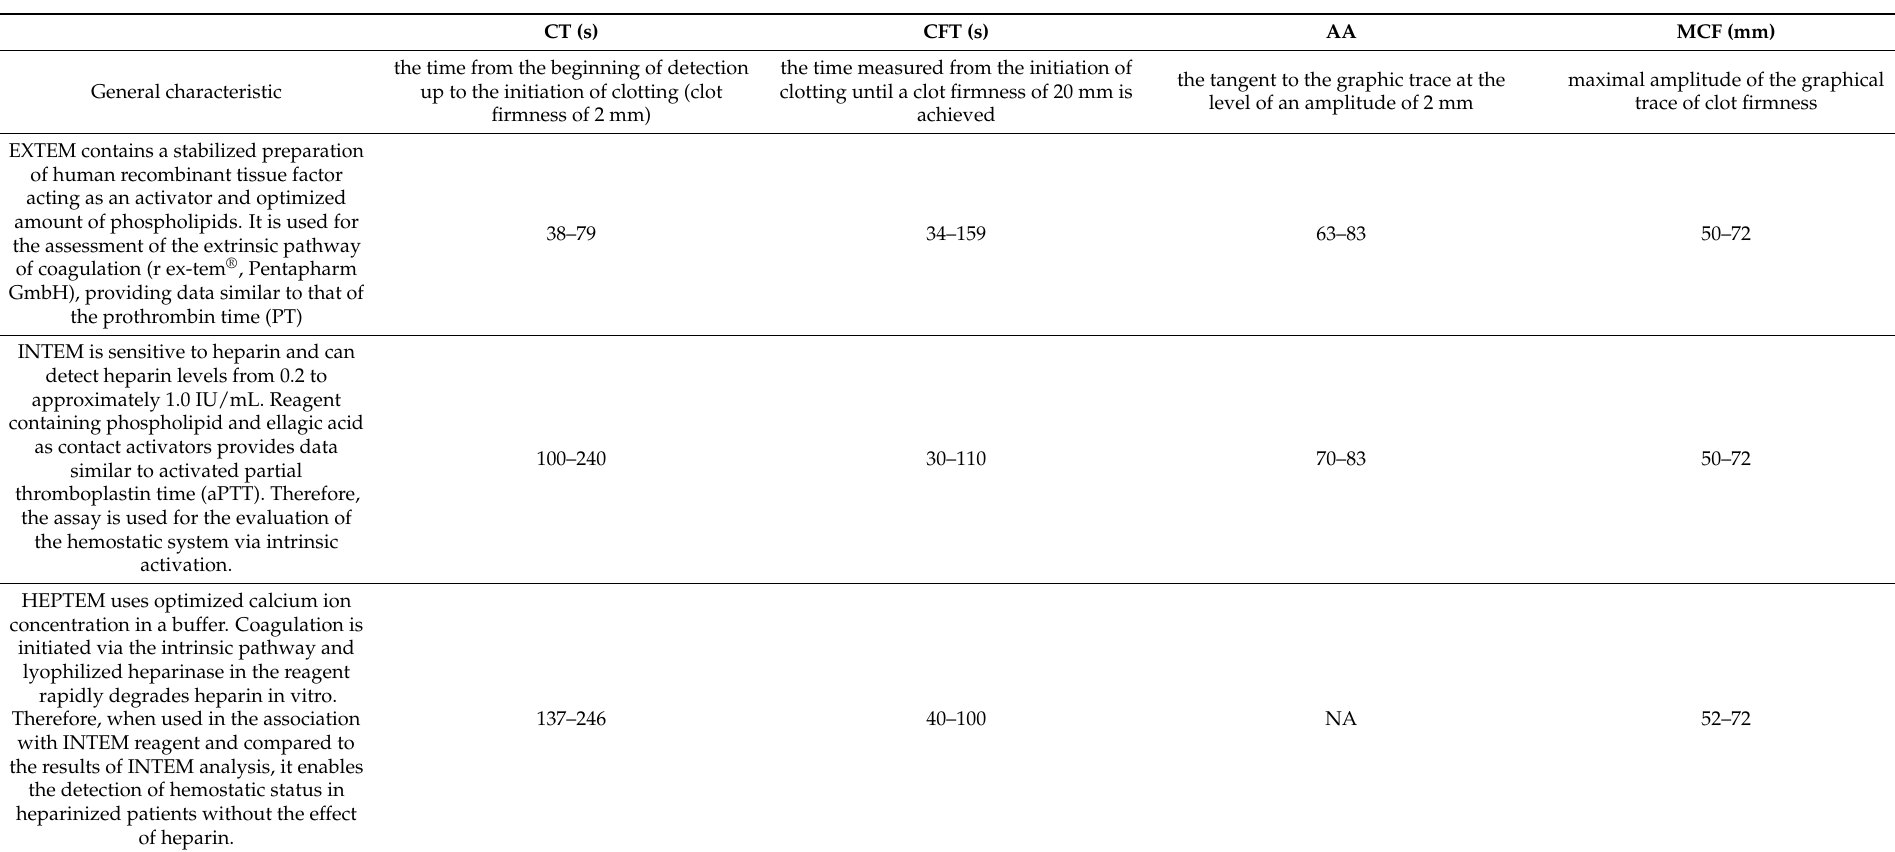
Table 1. General definitions and characteristics of the measured parameters and their reference ranges for particular tests used in the study ([10–18], r ex-tem ® , Pentapharm GmbH, in-tem ® , Pentapharm GmbH, hep-TEM ® , Pentapharm GmbH). CT (s) CFT (s) AA MCF (mm) the time from the beginning of detection the time measured from the initiation of the tangent to the graphic trace at the maximal amplitude of the graphical General characteristic up to the initiation of clotting (clot clotting until a clot firmness of 20 mm is level of an amplitude of 2 mm trace of clot firmness firmness of 2 mm) achieved